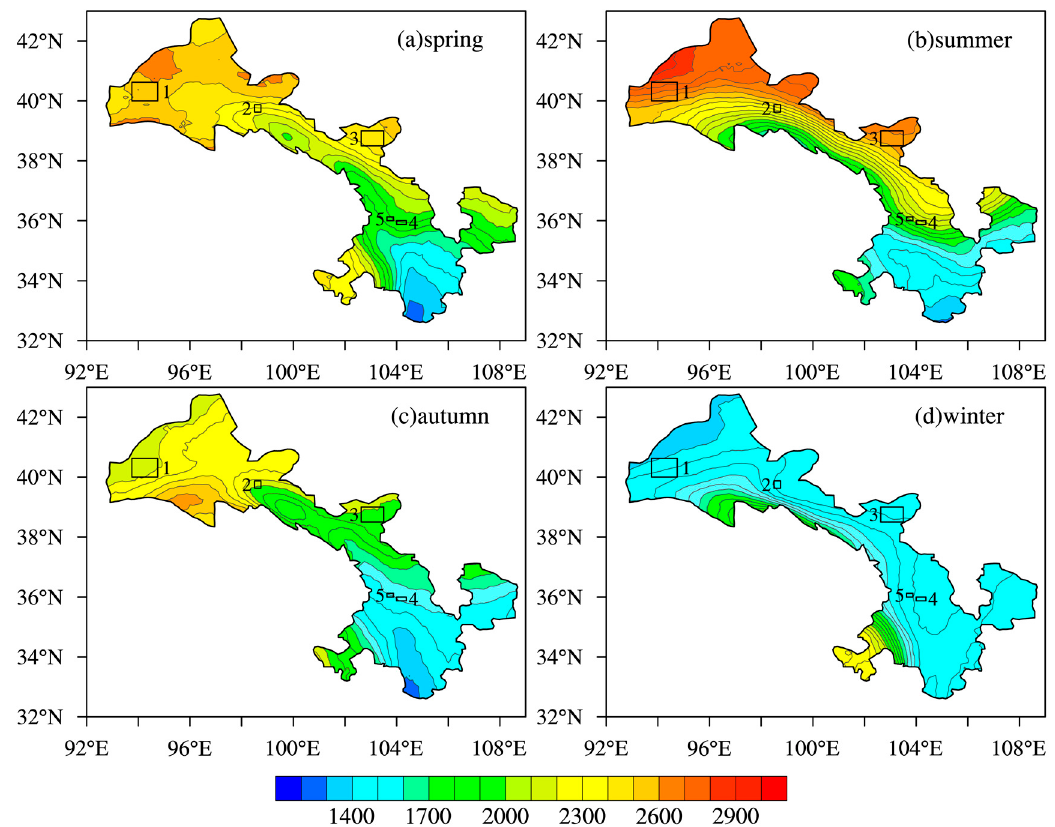
Figure 4. The spatial distribution of the atmospheric boundary layer height at 14:00 BJT, over Gansu province in northwest China, in four seasons of 2016: ( a ) spring, ( b ) summer, ( c ) autumn, and ( d ) winter. The five rectangles labeled 1–5 stand for the area positions of Dunhuang, Jiuquan, Minqin, Yuzhong and Lanzhou, respectively.